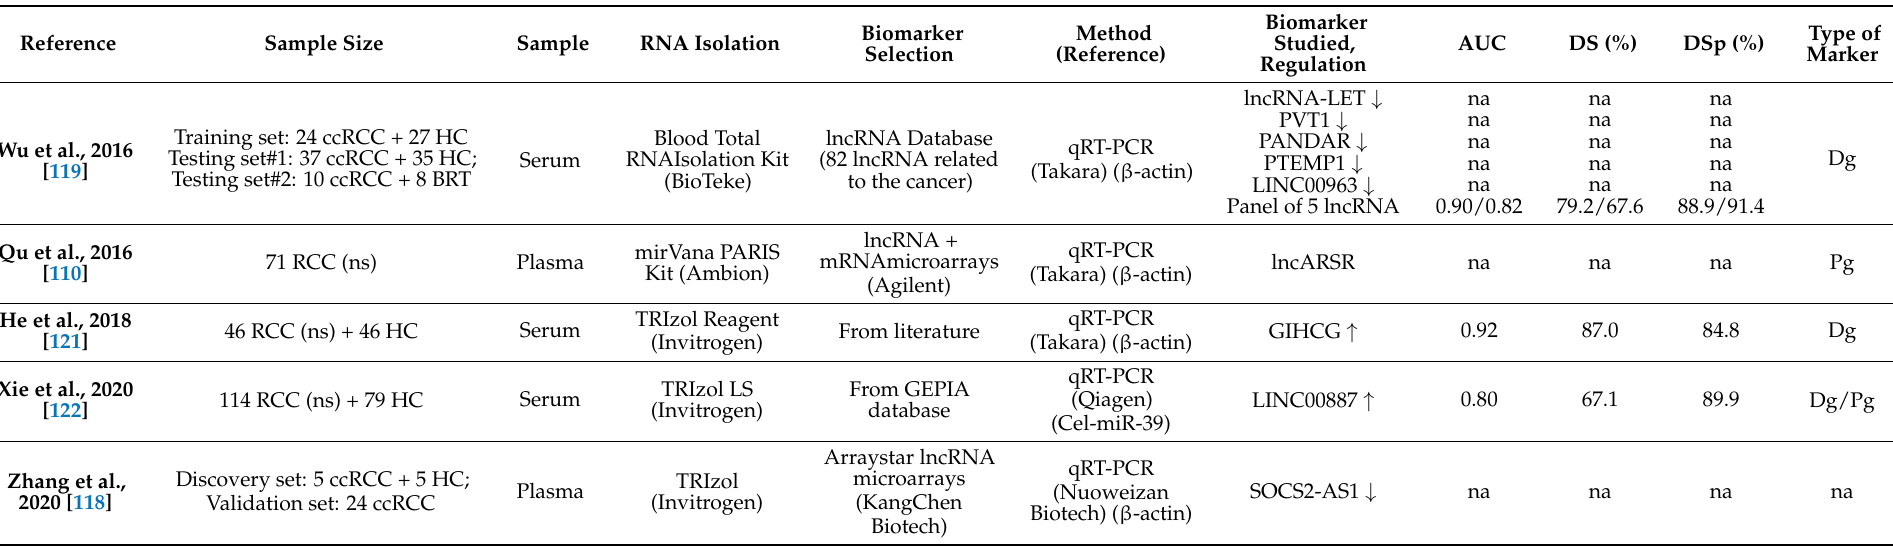
Table 3. Studies concerning lncRNAs in biofluids as a potential biomarkers of renal cell